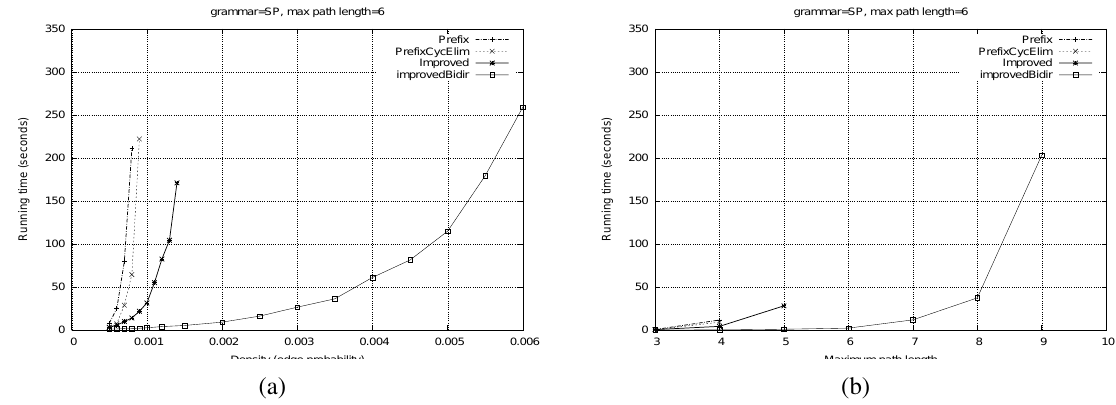
Figure 4: Average running times as a function of graph density (a) and maximum path length (b). In each run of the algorithm, two end-vertices were randomly chosen, and a connection